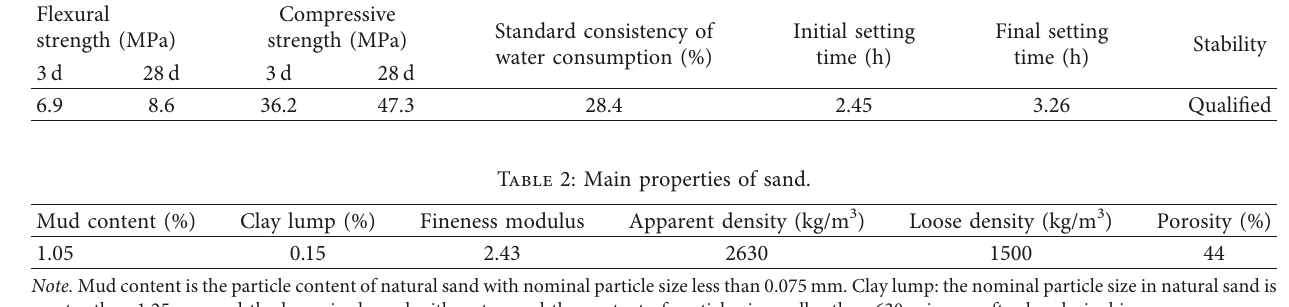
Table 1: Main properties of